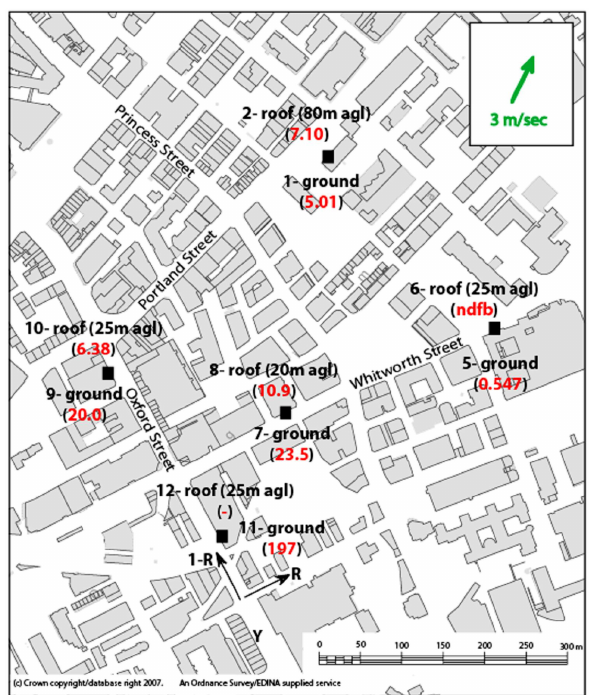
Figure 2. Second Cityflux perfluorocarbon tracer experiment including release 454 Fig. 2. Second Cityflux perfluorocarbon tracer experiment includ- position (Y) and sampling locations (1-2 and 5-12) showing height above ground 455 ing release position (Y) and sampling locations (1–2 and 5–12) level and results obtained (concentration/release rate) from the third sampling 456 showing height above ground level and results obtained (concen- period. “ndfb” = non-discernable from background, “-“ = failed sample. One 457 tration/release rate) from the third sampling period. “ndfb” = non- hour average wind conditions at Woodford Airport are shown in green (3 m sec - 458 discernable from background, “–“ = failed sample. One hour aver- age wind conditions at Woodford Airport are shown in green (3m s − 1 , 200 ◦ from